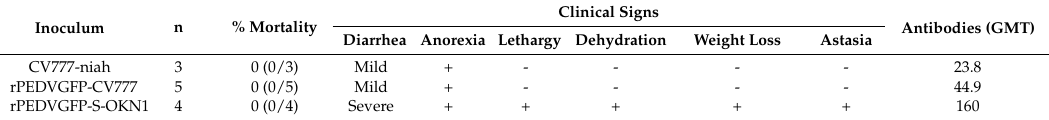
Table 2. Clinical signs and geometric mean titers of antibodies at 28 days post-infection in piglets inoculated with CV777 maintained in National Institute of Animal Health, CV777 recombinant, and S-chimeric PEDV strains. Clinical Signs Antibodies (GMT) Inoculum n % Mortality Diarrhea Anorexia Lethargy Dehydration Weight Loss Astasia CV777-niah 23.8 rPEDVGFP-CV777